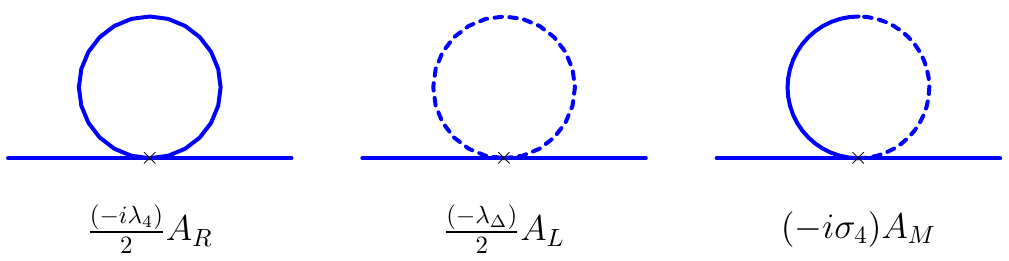
Figure 5. One loop correction to m 2 due to quartic couplings.